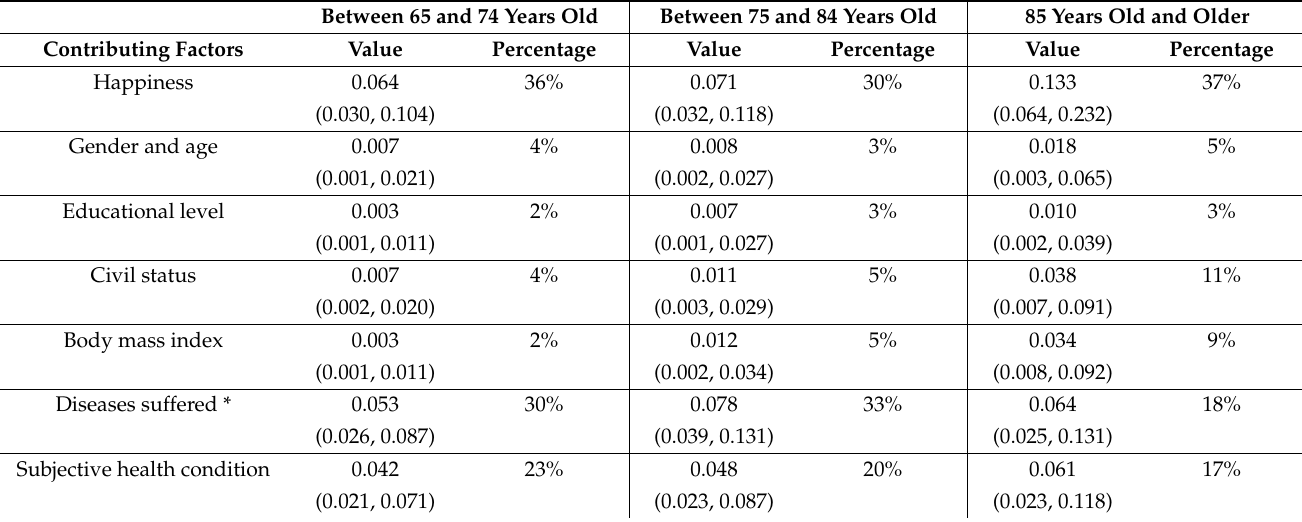
Table 1. Shapley–Owen–Shorrocks decomposition of subjective life